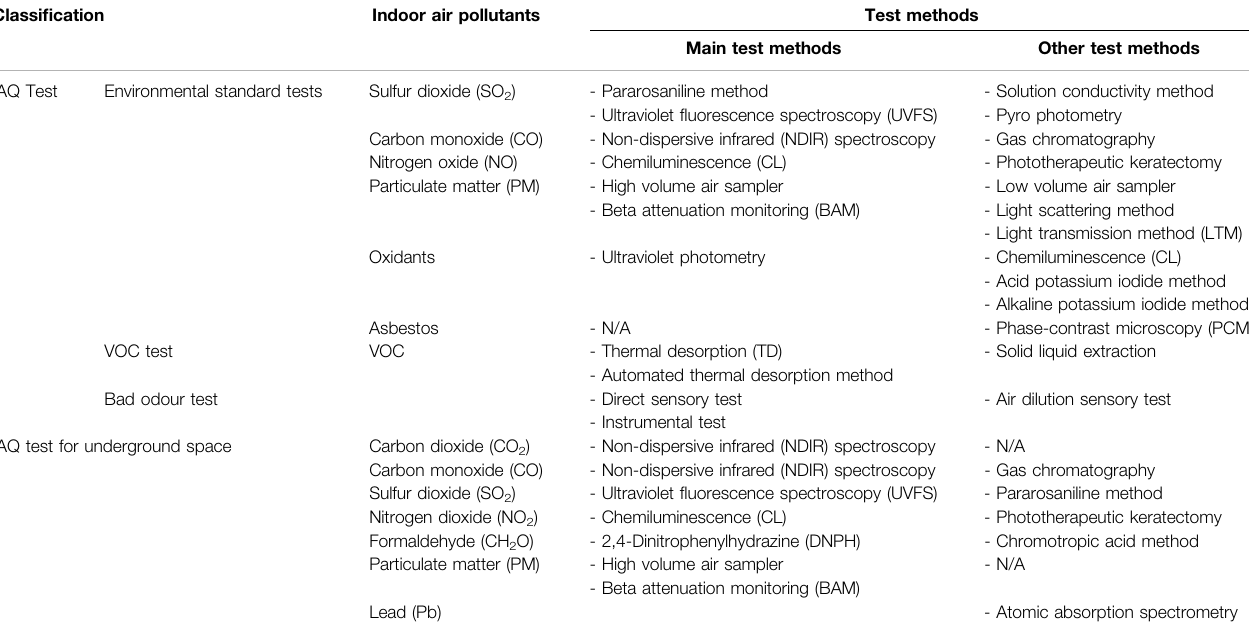
TABLE 3 | Classi fi cation of measurement methods by indoor air